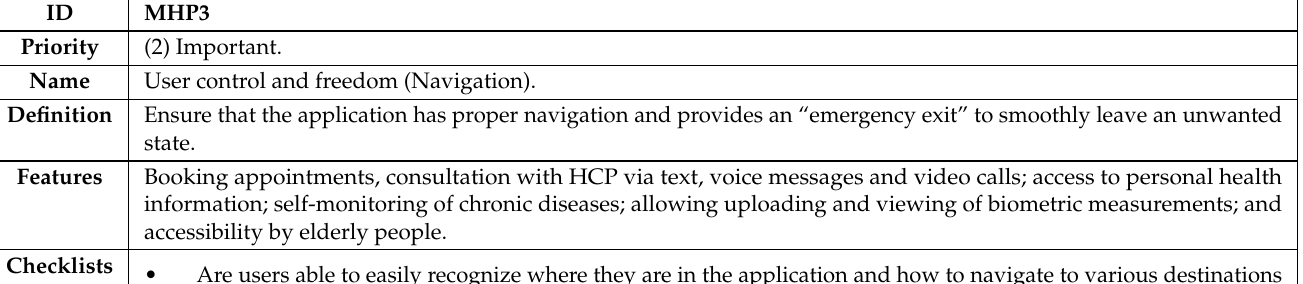
Table A3. Descriptive details of the third guideline.